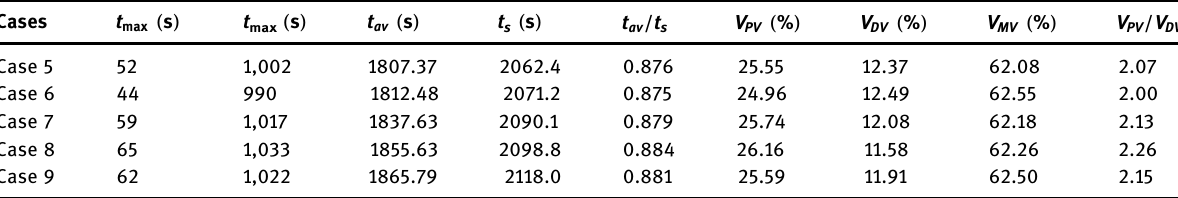
Table 5: Analysis results for the RTD curve for case 5 to case 9 Cases